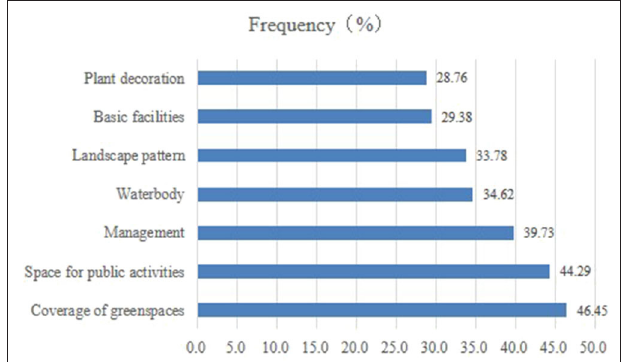
FIGURE 5 | Correlation between the total satisfaction on cultural ecosystem services (CES) and the real vegetation coverage.